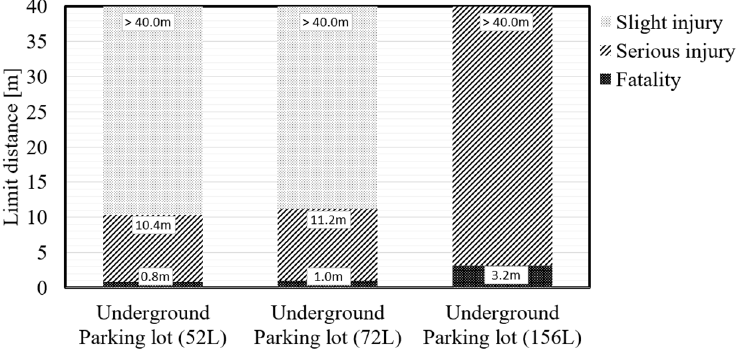
Figure 17. Limit distances according to tank capacity in the underground parking garage.